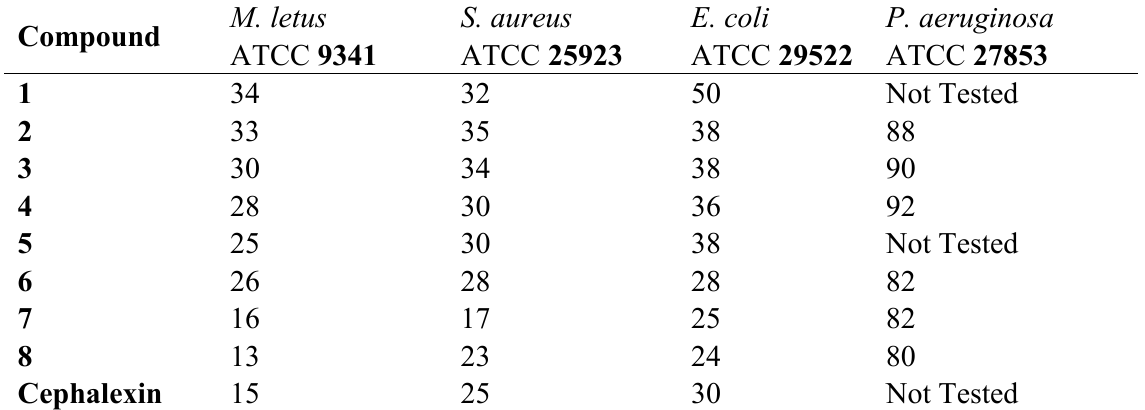
Table 2. Minimum inhibitory concentrations of the newly synthesized cephalosporins (MIC values, μ